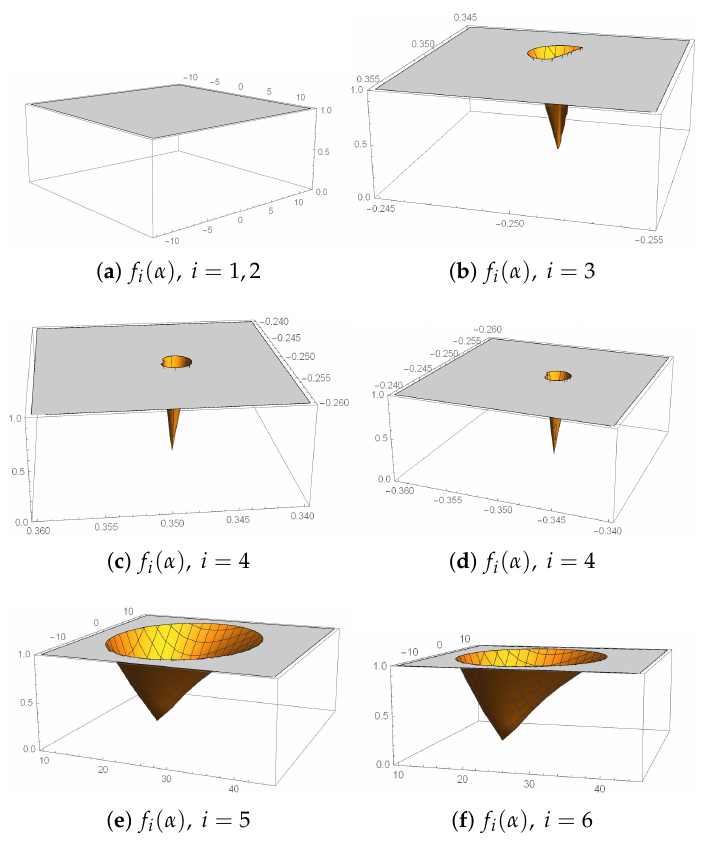
Figure 2. Regions of stability corresponding to f i ( α ) , i = 1,2, . . .